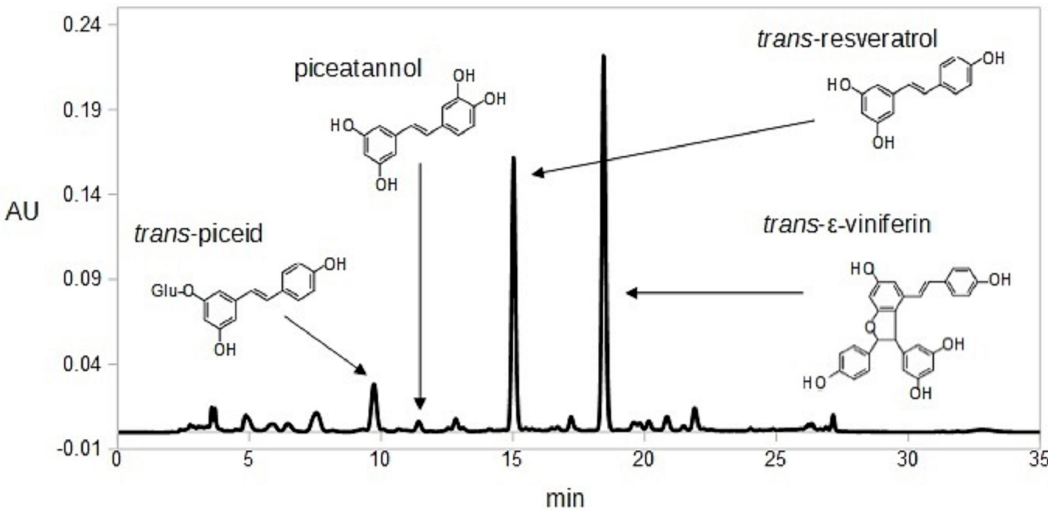
Figure 1. HPLC-DAD chromatogram corresponding to Malbec cultivar grape cane sample and structure of the studied compounds.